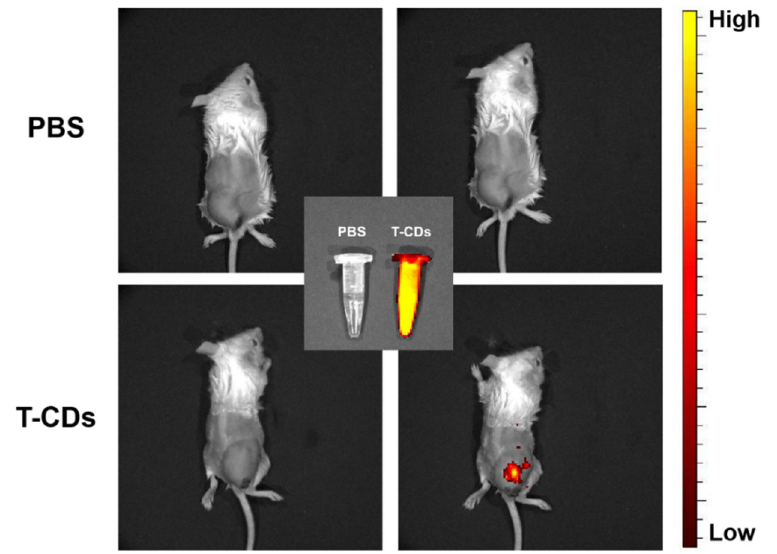
Figure 8. In vivo fluorescence images of mice treated with intratumoral injection of PBS and T − CDs (λ ex = 600 nm, λ em = 670 nm). (Inset: fluorescence images of PBS and T − CDs solution.). These results indicate that T − CDs have a good biological imaging effect in the red light region and can cross the nuclear membrane and accumulate in the nucleolus region.